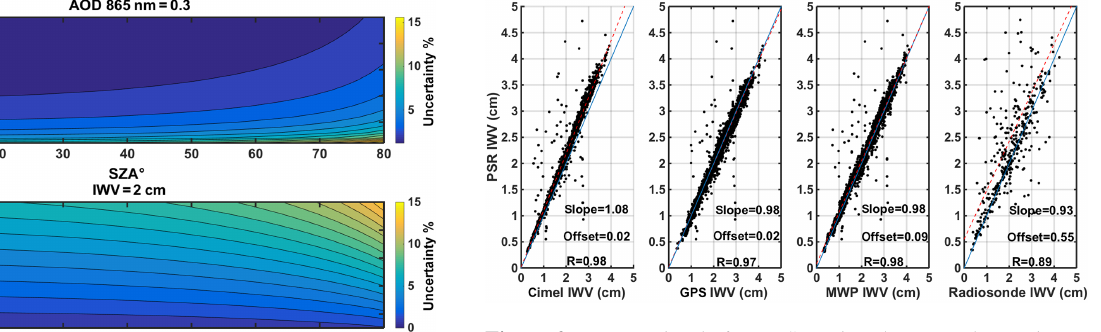
Figure 9. IWV retrievals from PSR using the monochromatic ap- proach at 946nm compared to synchronous ones of CIMEL, GPS, MWP and radiosonde for the full 2-year measuring